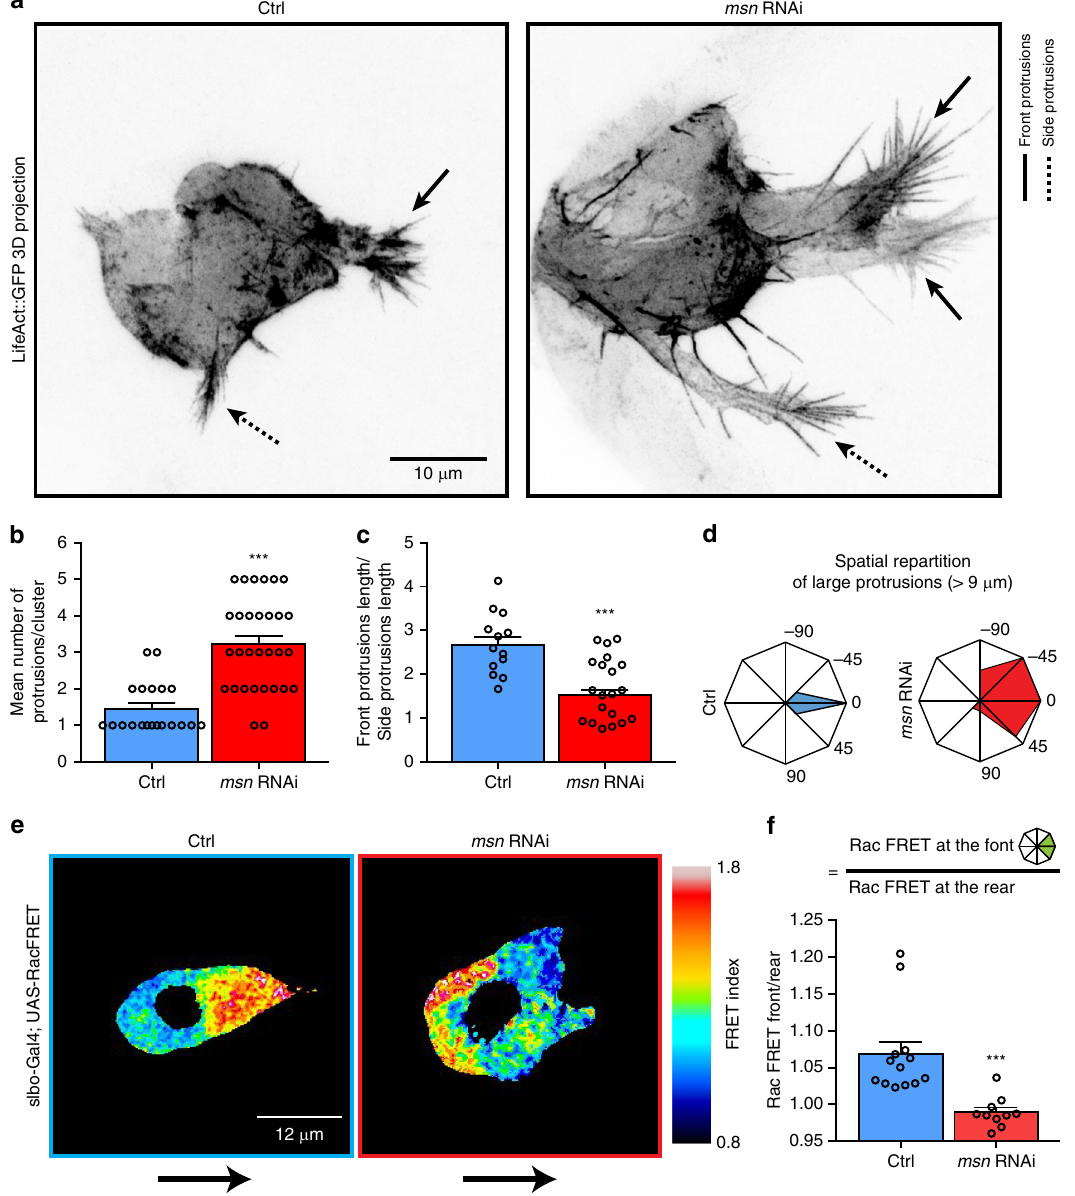
Fig. 3 Msn restricts large protrusions and Rac activity to the leader cell. a Z-projection of LifeAct::GFP expressing control and Msn - depleted clusters shown in inverted greyscale. Plain arrows point to protrusions at the front of the clusters and dotted arrows point to protrusions at the side. 3D representation of the clusters are shown in Movies 3 and 4. b Quanti fi cation of the mean number of protrusions per cluster in both control and Msn - depleted clusters ( n = 20 and n = 30, respectively). Any protrusions larger than 4 μ m were manually counted using 3D fi xed samples expressing LifeAct::GFP. c Ratio of front and side protrusion lengths in control and Msn-depleted clusters ( n = 13 and 20, respectively). d Analysis of the orientation of protrusions longer than 9 μ m in control and Msn-depleted clusters ( n = 13 and 20, respectively). e Processed FRET signal images from border cells expressing UAS-Rac FRET under the Slbo- Gal4 promoter in control and Msn-depleted clusters, at the onset of migration. FRET signal images are color-coded in 16 bit LUT from ImageJ. n = 10 for each conditions. Black arrows indicate the direction of migration. f Quanti fi cation of the ratio of the FRET indexes measured at front and back of control and Msn-depleted clusters ( n = 13 and n = 10 independent BC cluster, respectively). Histogram represents the means of fi ve different planes for each cluster. *** p < 0.001, unpaired Student ’ s t -test. Error bars show s.e.m. n represents the number of independent BC